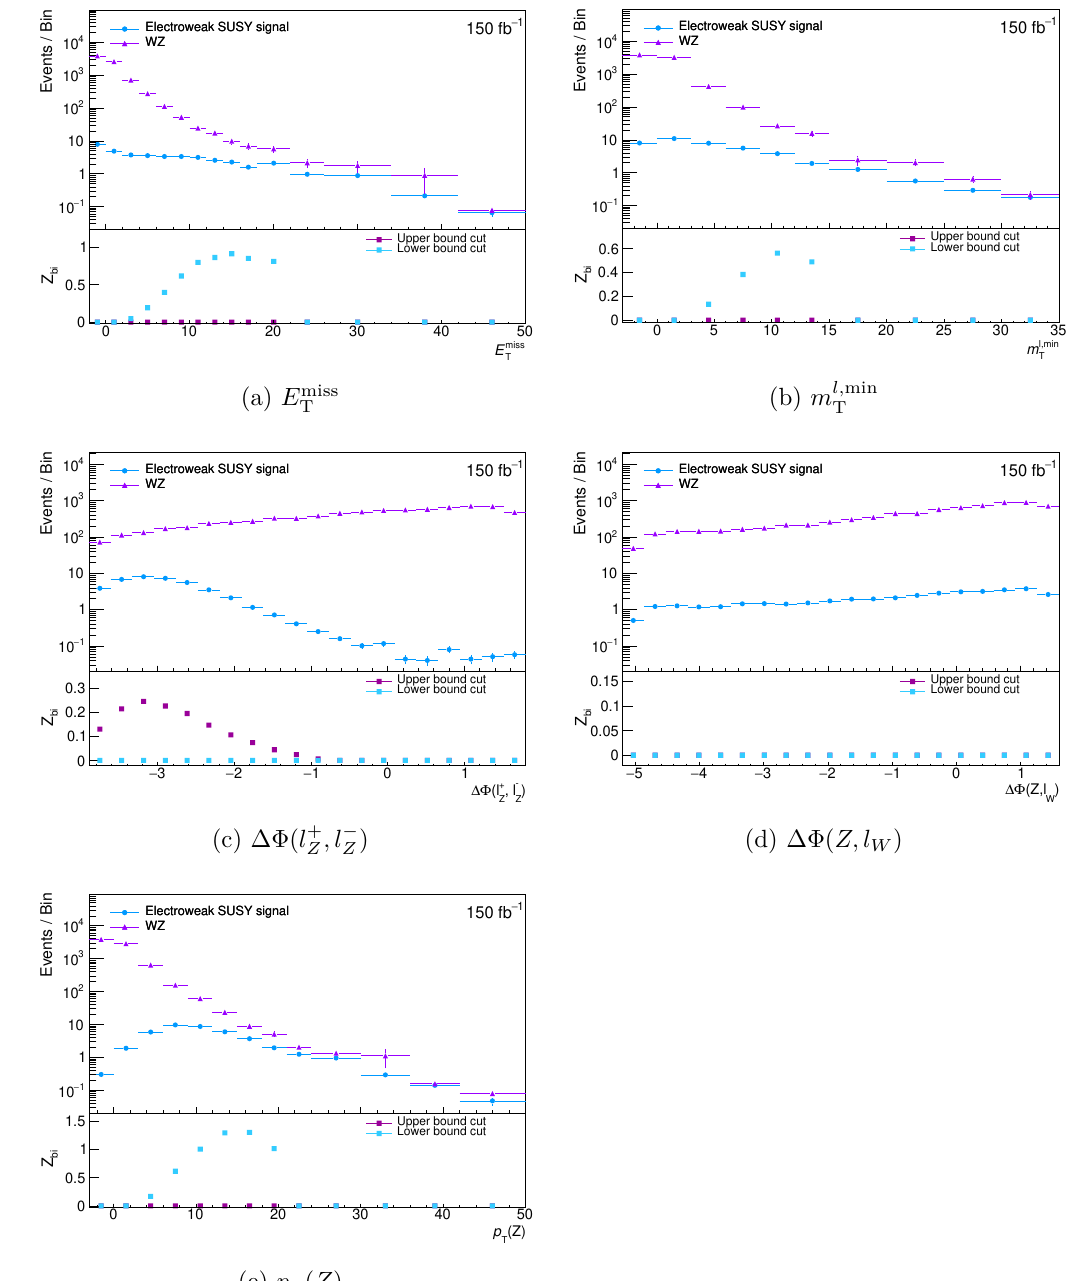
Figure 3. Event rates as a function of the kinematic variables used in our prototype electroweakino search, with the median scaling applied. Events in the overflow bin are not shown in the distribution but are included in the Z bi